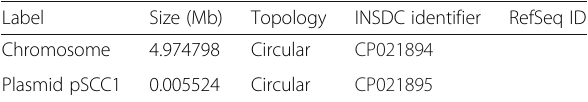
Table 3 Summary of P. carotovorum SCC1 genome: one chromosome and one